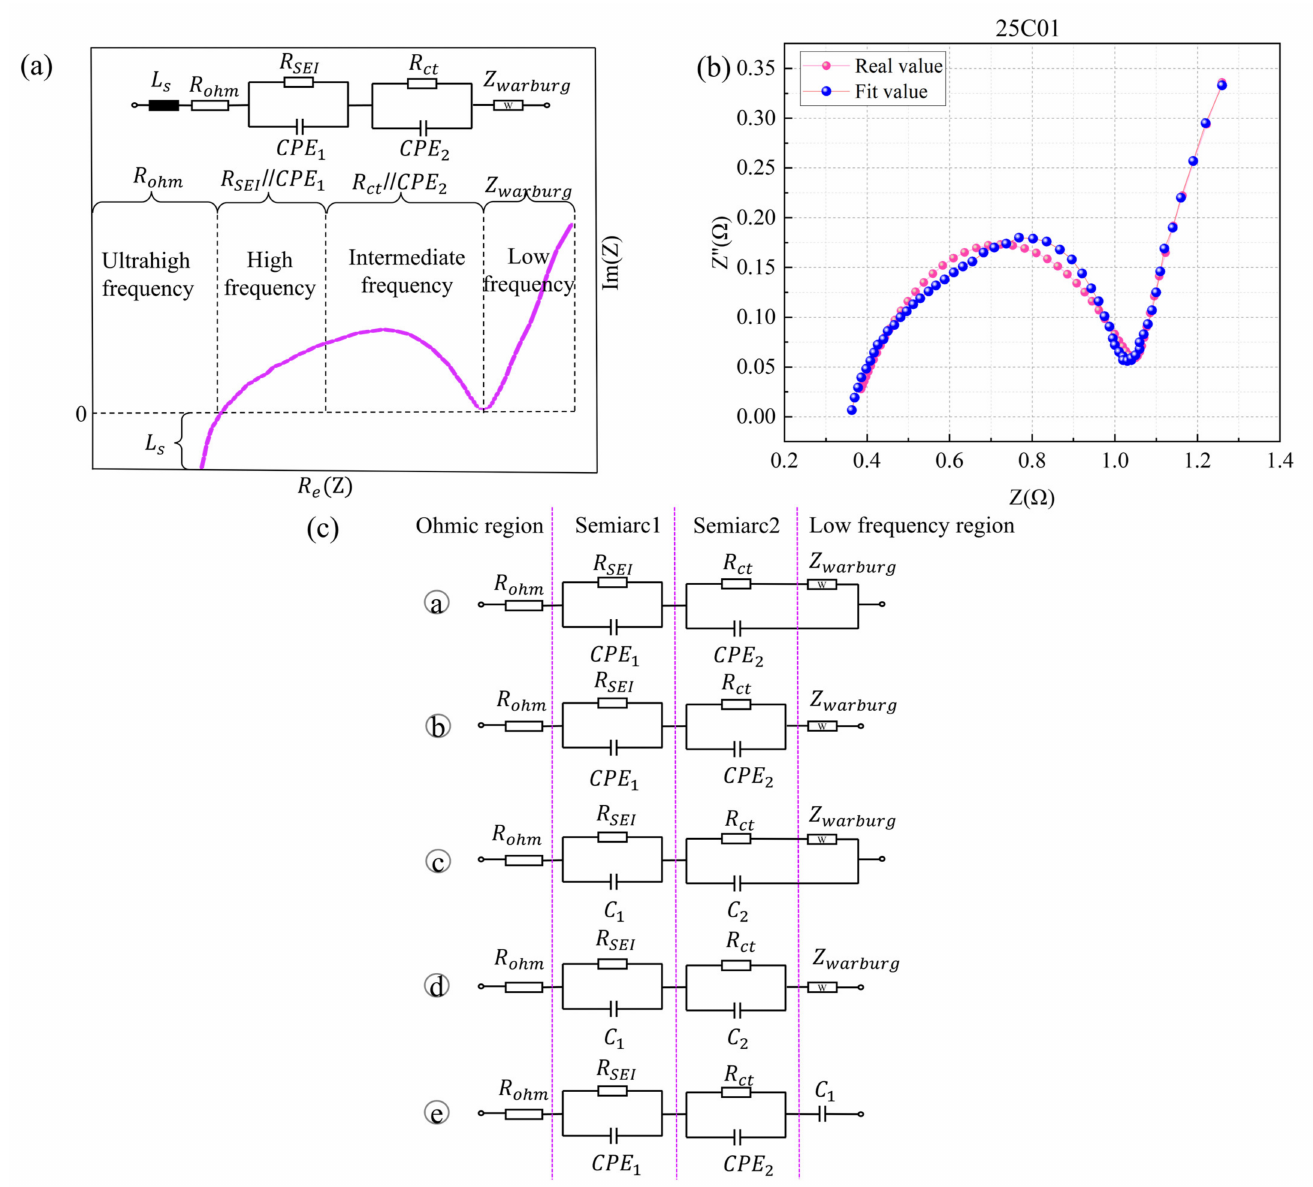
Figure 3. ( a ) Fit the equivalent circuit. ( b ) Impedance fitting curve. ( c ) Different equivalent circuit diagram. α 1 , α 2 , β 1 and β 2 are parameters that need to be determined, and T represent